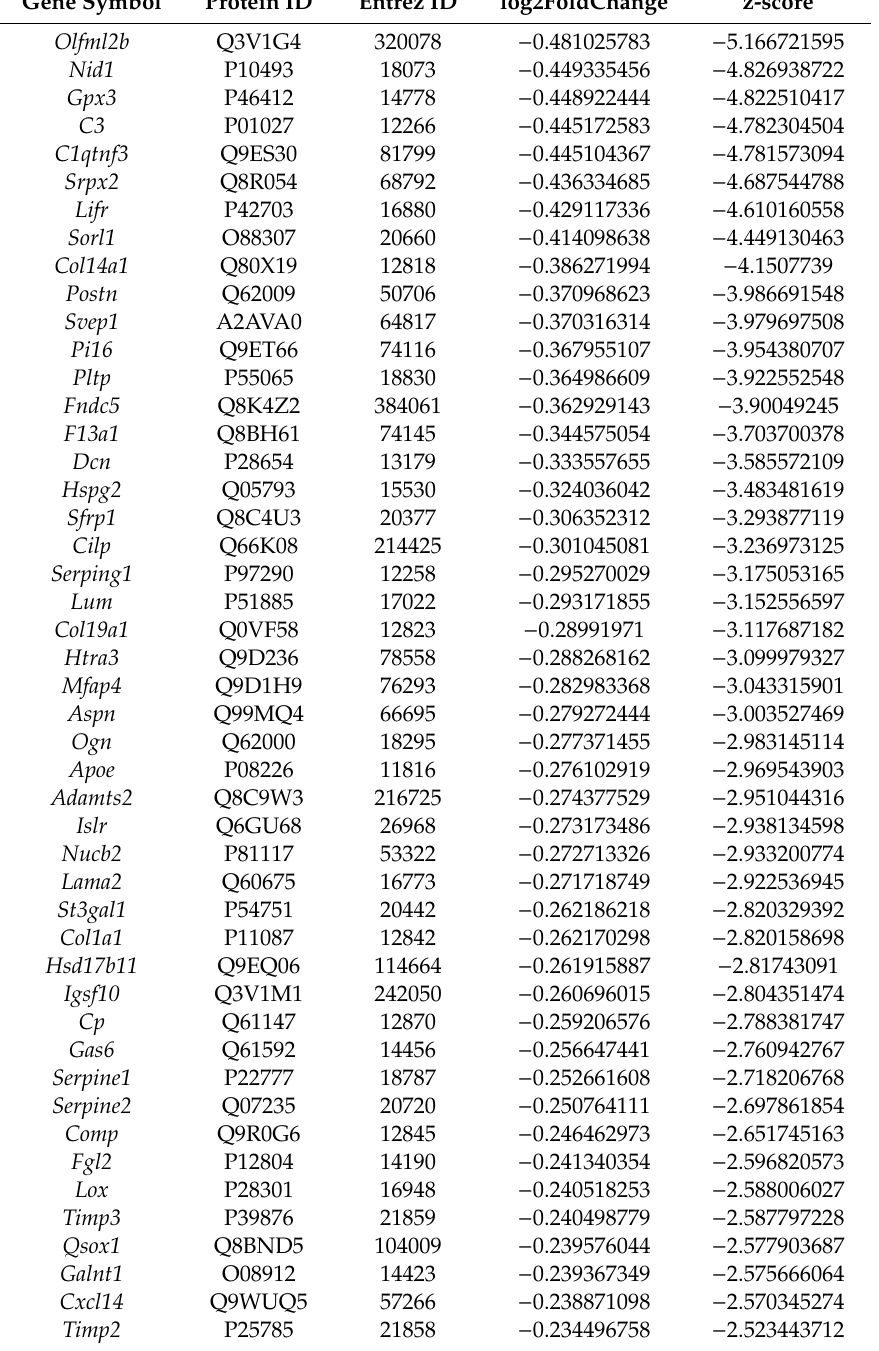
Table2. Downregulatedgenesencodingsecretoryproteinsfollowing Myoparr knockdownindenervated TA muscle of C57BL / 6J